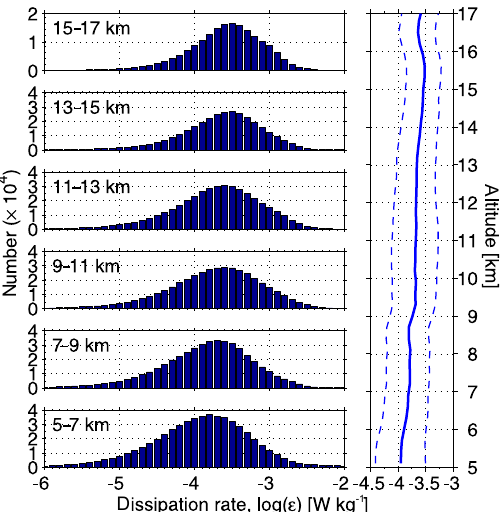
Figure 8. Histogram of the logarithm of the derived ε within the altitude ranges of 2km each as well as the vertical profiles of the logarithm of the ε median (solid line) and the upper and lower quar- tiles (dashed lines) based on all 522-day radar observations with MAARSY during the period of